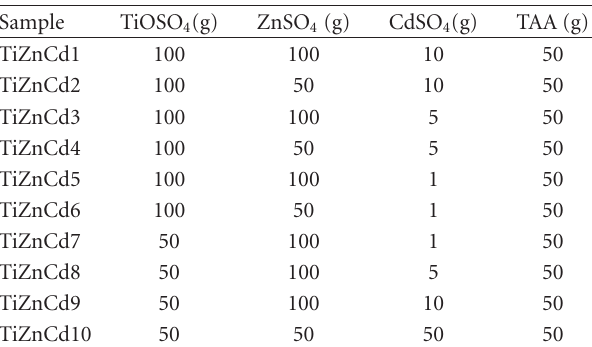
Table 1: Reaction conditions of nanocomposites TiO 2